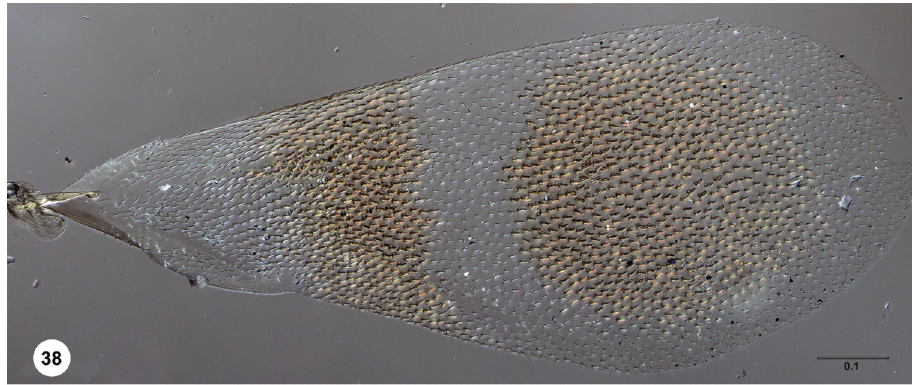
Figure 38. Pulchrisolia nephelae , female (OSUC 697956) 38 fore wing, slide mount. Scale bar in micrometers.